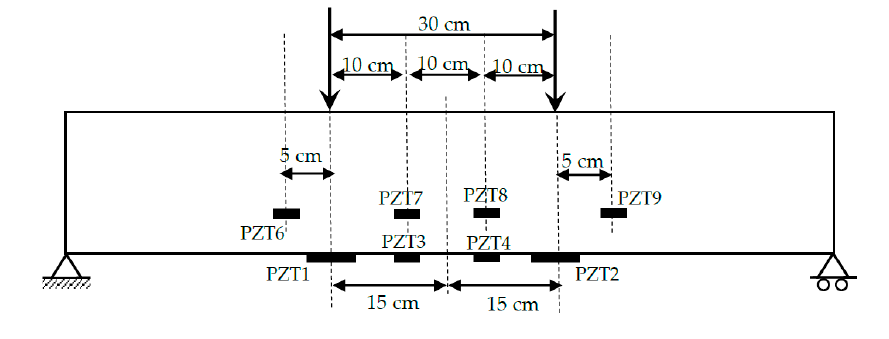
Figure 1. Test setup of specimen A.